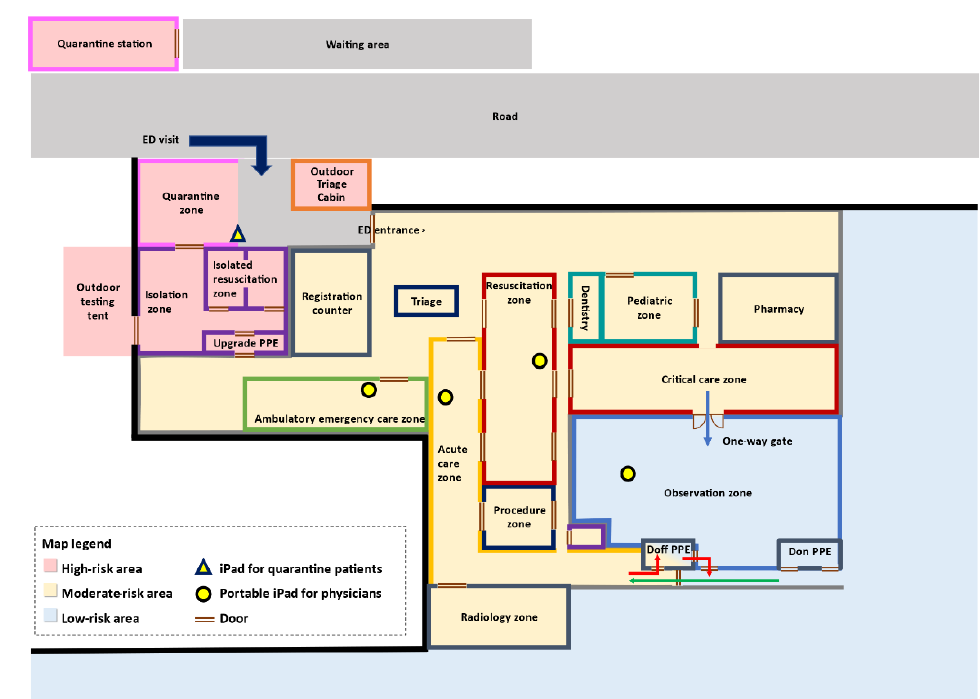
Figure 1. Modified floor plan during the COVID-19 pandemic. The ED was sectioned into three main areas: high-risk (pink), moderate-risk (yellow), and low-risk (blue) areas. High-risk areas included an outdoor triage, a quarantine zone, a quarantine station, and an isolation area that was composed of an isolation zone, two isolated resuscitation rooms, and a room to don and doff PPE. The moderate-risk area included an indoor triage, a resuscitation zone and a critical-care zone for critically ill patients, an ambulatory emergency care zone, and an acute care zone. The low-risk area (blue) consisted of an observation zone, where patients with negative COVID-19 PCR tests awaited admission or further management, and rooms to don and doff PPE. The blue arrow shows a one-way path to reallocate patients from moderate-risk areas to low-risk areas. The green arrow shows the direction of the staff flow to don PPE. The red arrow shows the direction to doff PPE and leave the ED. The iPad in the quarantine zone was placed on an immobile tablet security stand (triangle), and two iPads were given to physicians in the resuscitation zone, ambulatory emergency care (AEC) zone, acute care zone, and observation zone (circles).